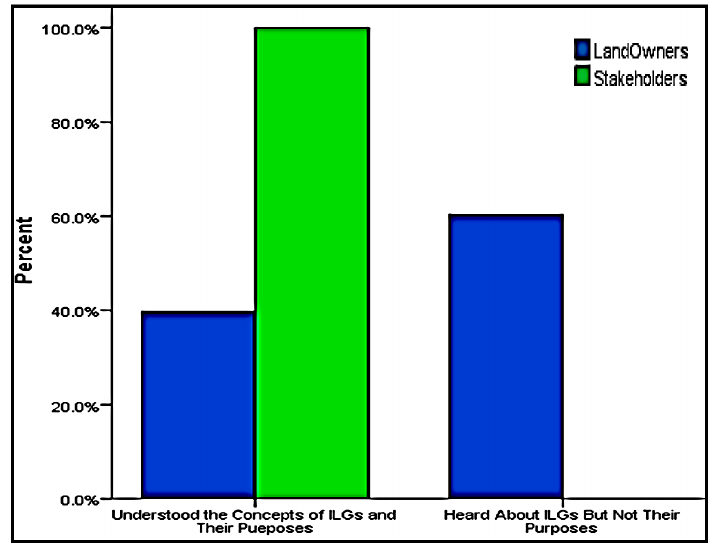
Figure 5. Respondents’ Awareness of ILGs’ Functions in Papua New Guinea.